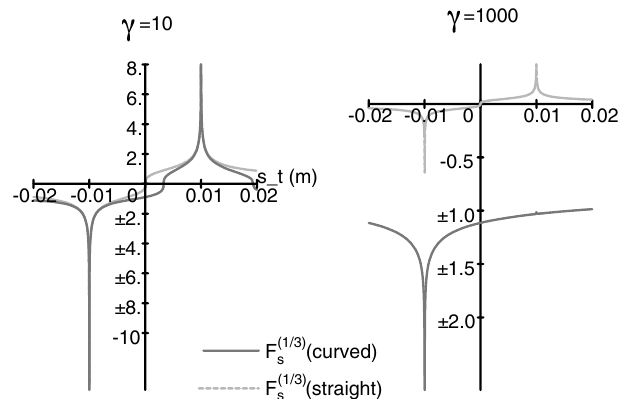
FIG. 12. The curved string and straight string longitudinal forces (after taking their cube roots) are shown over a range extended in front of and behind the string. (There is nothing fundamental about cube root; this function has been chosen only to expand the scale at low amplitude relative to that at large amplitude while otherwise preserving the general shape.) As (cid:23) increases, the straight string force becomes negligible compared to the curving string case. R (cid:1) 10 m , L (cid:1) 0 : 01 m .